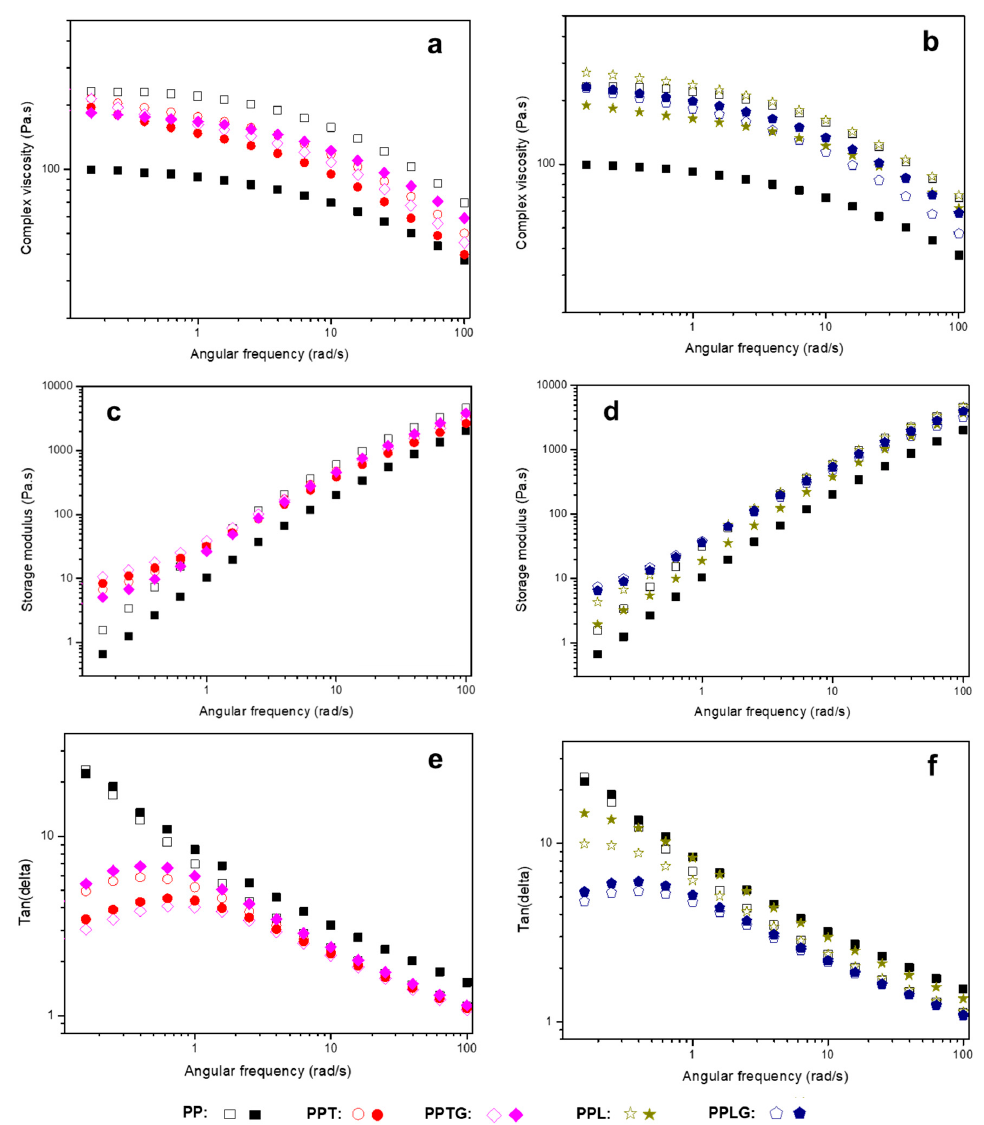
Figure 10. A comparison of rheological behavior of PP, PP/tannin blends (left), and PP/lignin blends (right) at 168 h UV weathering: ( a , b ) complex viscosity; ( c , d ) storage modulus; ( e , f ) tan(delta).